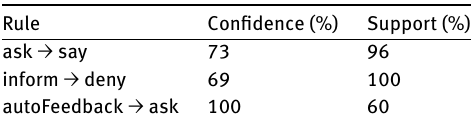
Table 2: Representation of the temporal rules mined with Titarl algorithm.